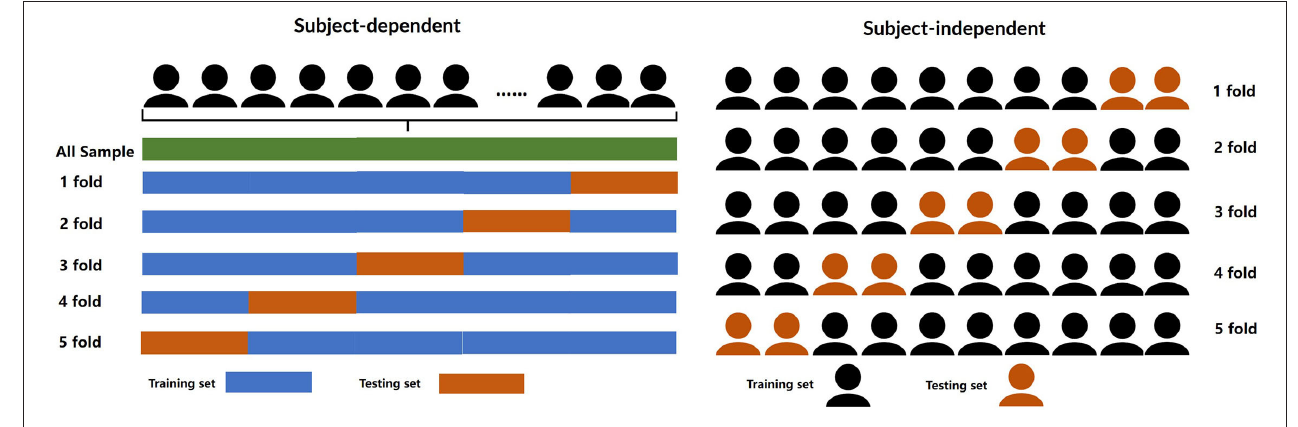
FIGURE 3 | The divided methods of different experiments.